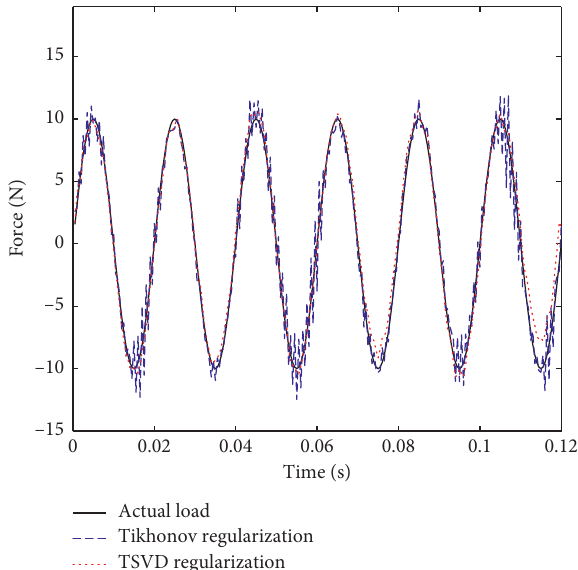
Figure 3: Identification results of sinusoidal loads at 5% noise level.